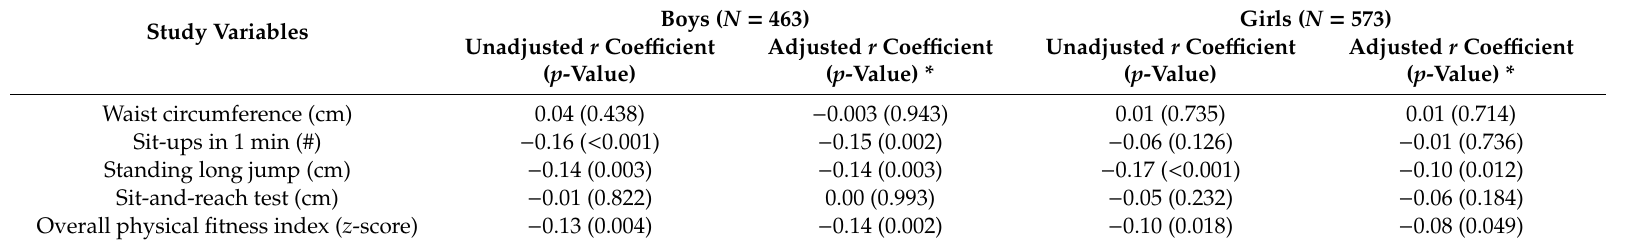
Table 2. Correlation analysis between pain intensity and physical fitness in boys and girls, Croatia